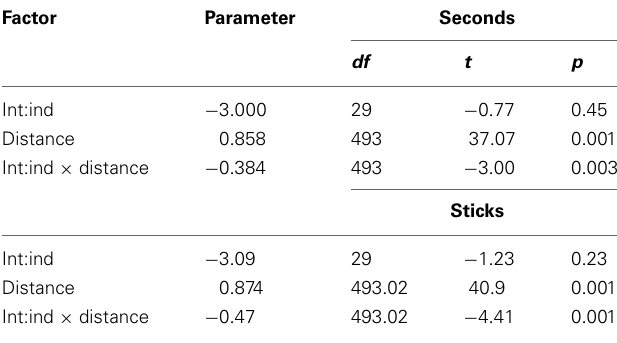
Table 1 | Parameter estimates (in seconds, upper panel) or stick-number estimates (lower panel) to walk to or touch American confederates.